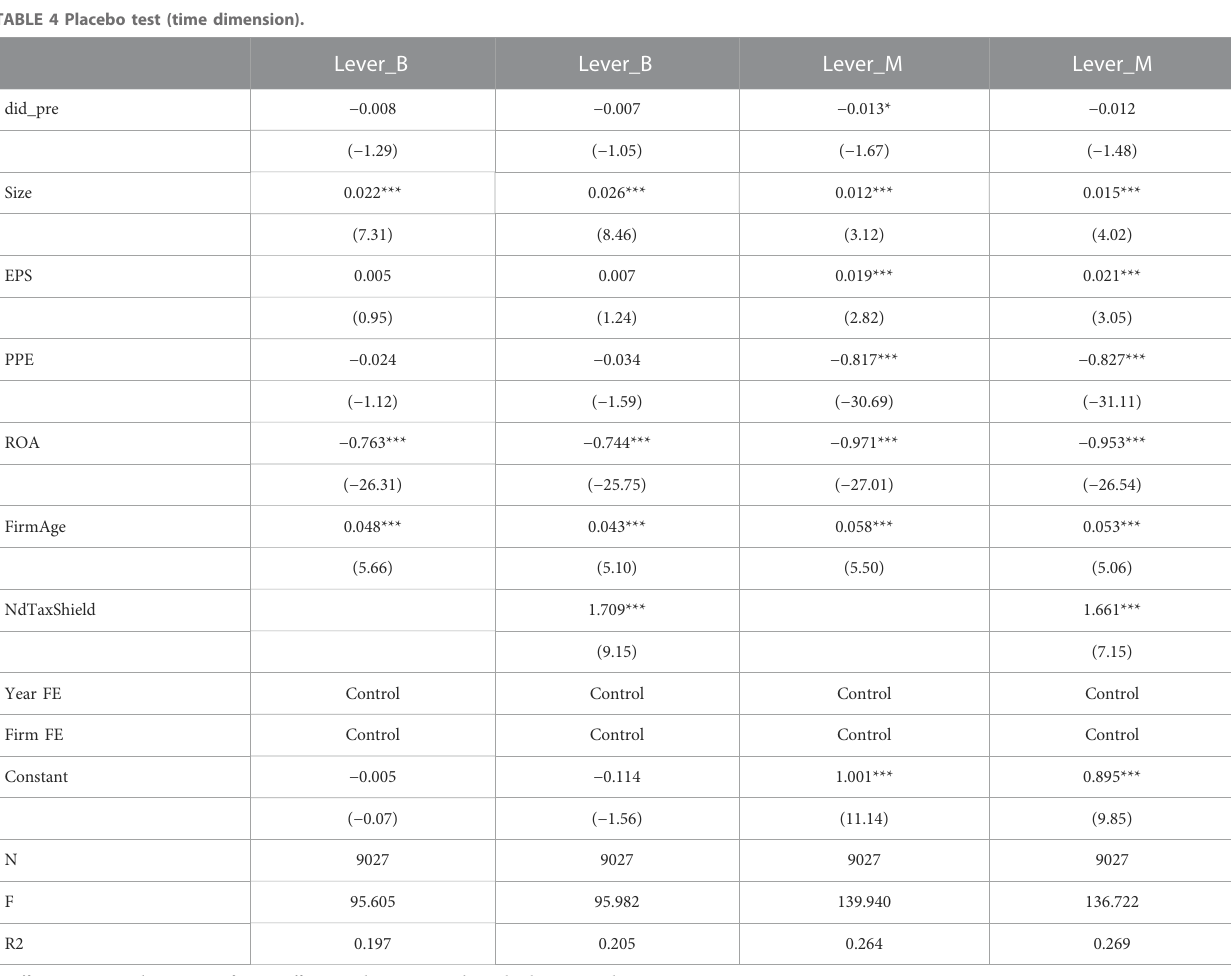
TABLE 4 Placebo test (time